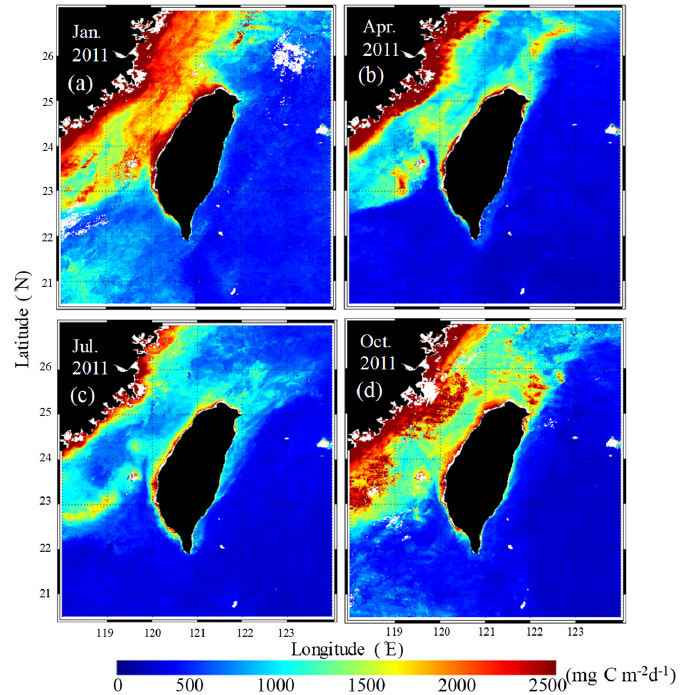
Figure 4. Monthly mean spatial distributions of VPGM PP derived from PP A&T in 2011: ( a ) January, ( b ) April, ( c ) July, and ( d ) October.